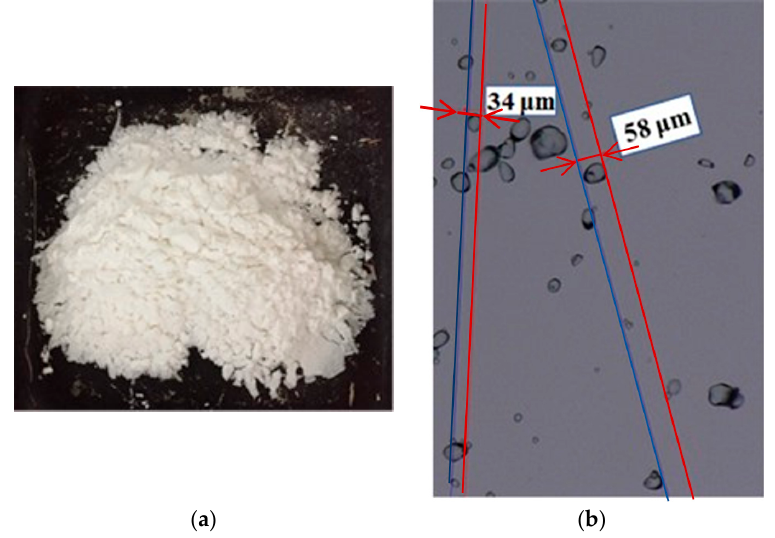
Figure 3. ( a ) Powder of potato starch; ( b ) potato starch grains seen by optical microscopy.